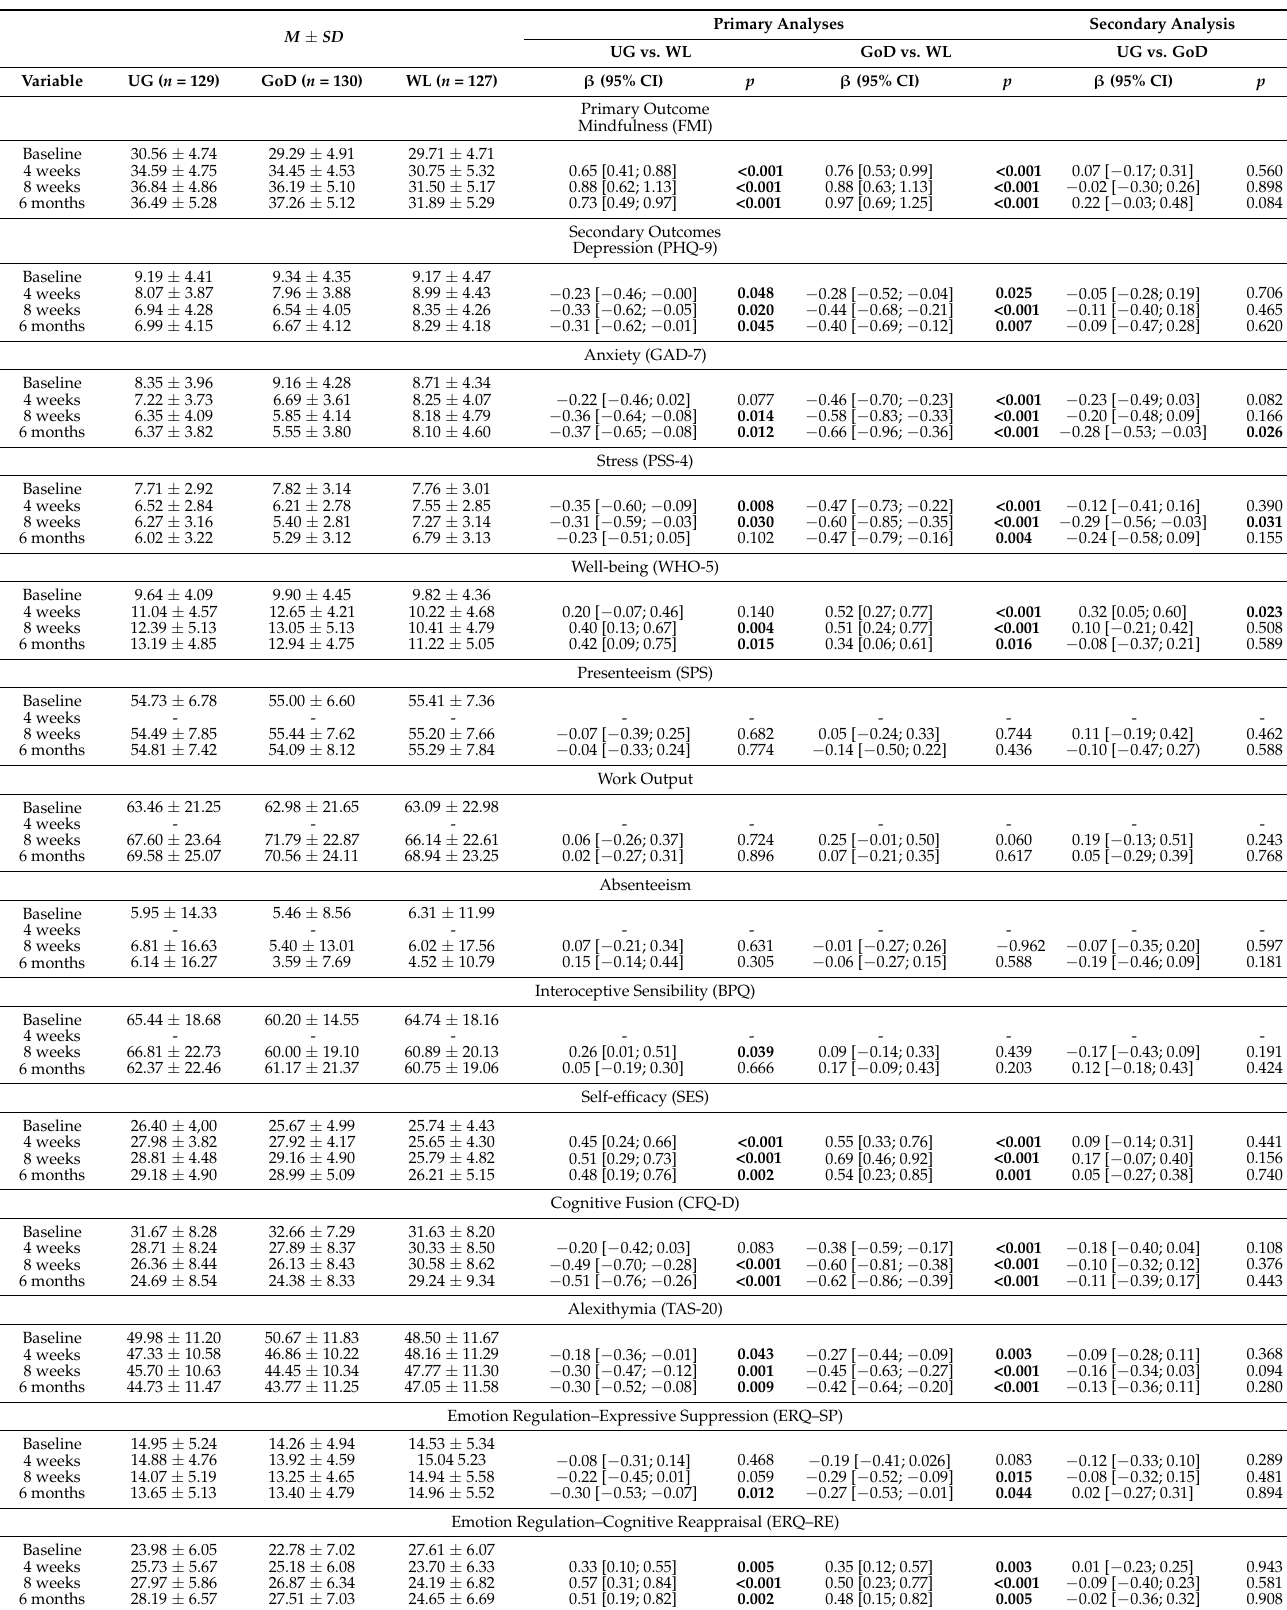
Table 3. Results of regression analyses